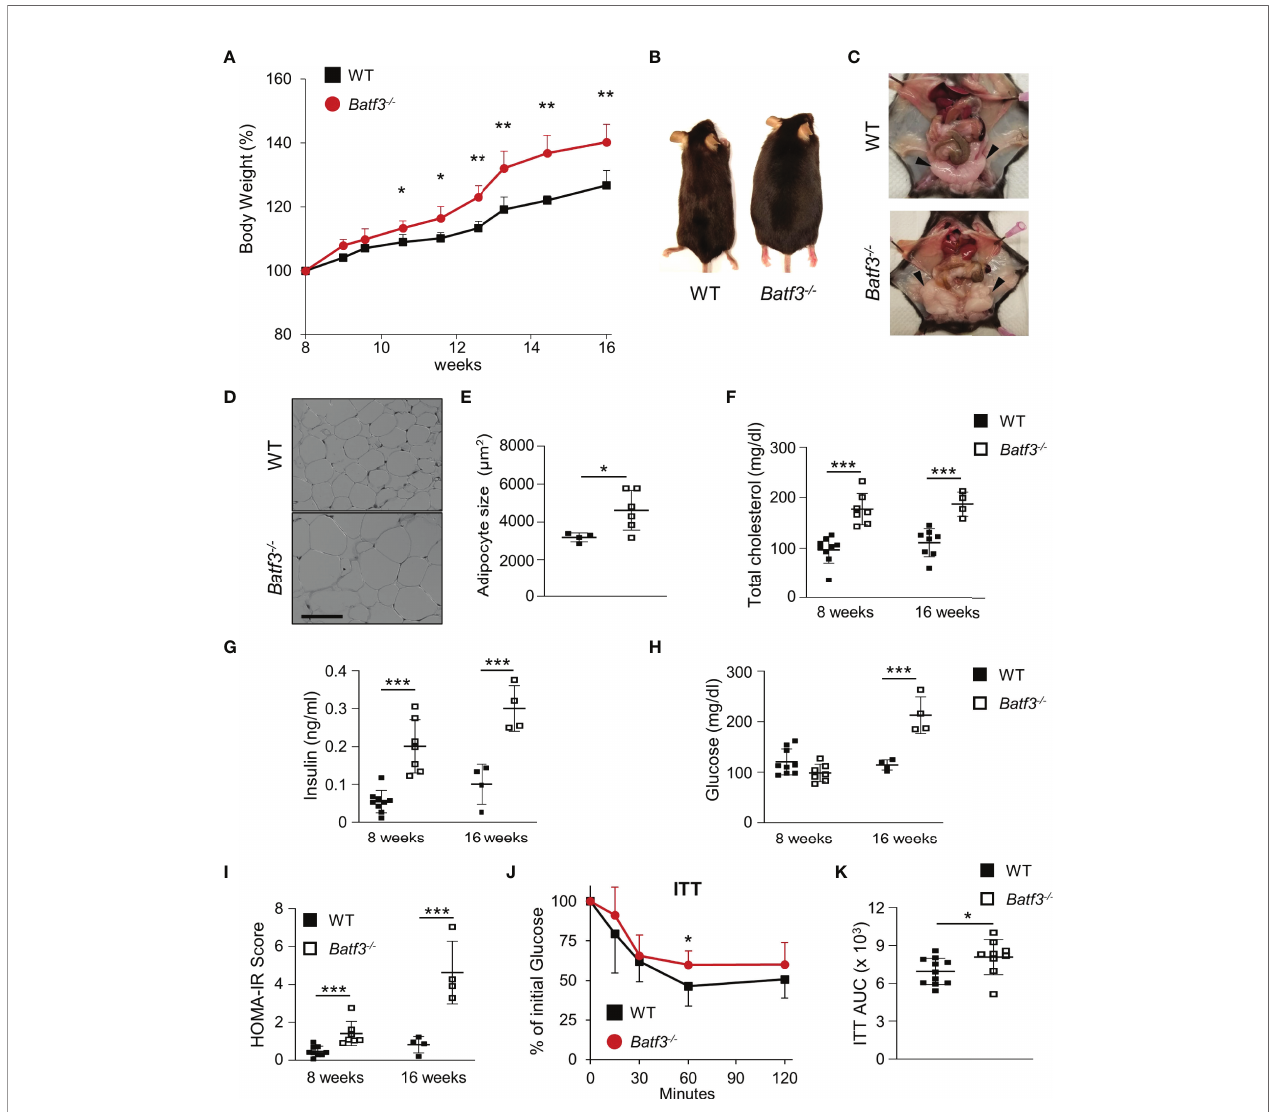
FIGURE 1 | Batf3 -/- mice develop metabolic syndrome. (A) Body weight gain as percentage of the initial weight at 8 weeks (n = 4/group). (B, C) Representative images of WT and Batf3 -/- mice (B) and abdominal cavity (C) indicating gonadal white adipose tissue (GWAT; black arrow heads) at 6 months of age. (D) Representative H&E staining of GWAT at 16 weeks of age (Scale bar, 100 m m). (E) Quanti fi cation of adipocyte sizes (100 adipocytes/mouse; n = 4-6/genotype). (F) Serum total cholesterol concentrations after overnight fasting (8 weeks, n = 7-9/genotype; 16 weeks, n = 4-8/genotype). (G – I) Serum insulin concentrations (G) , fasting blood glucose concentrations (H) , and homeostatic model assessment for insulin resistance (HOMA-IR) score (I) at 8 and 16 weeks of age (8 weeks, n = 7-9/genotype; 16 weeks, n = 4-8/genotype). (J, K) Insulin tolerance test (ITT) (J) and area under the curve (AUC) analysis of ITT (K) in WT and Batf3 -/- mice at 16 weeks of age (n = 9-11/genotype). Data are represented as means ± SD. Statistical signi fi cance was determined by Student ’ s t -test. * p < 0.05, ** p < 0.01, *** p <